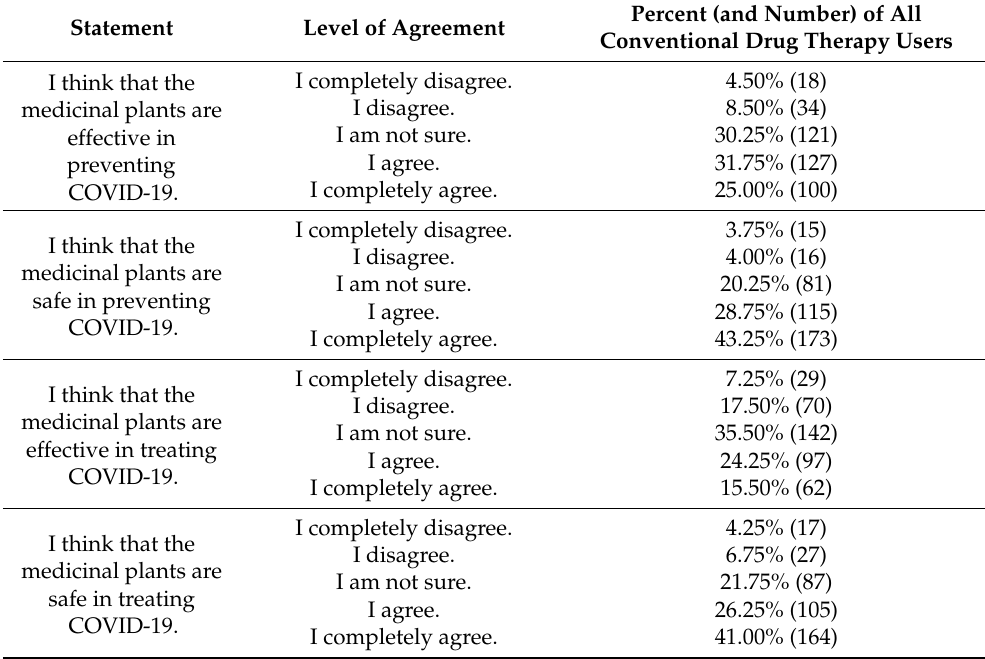
Table 6. The opinion on the efficacy and safety of phytotherapy against